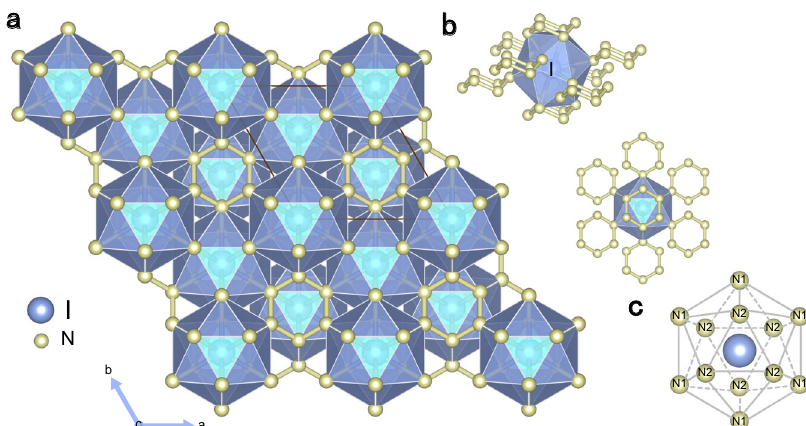
Fig. 2 Schematic representation of IN 6 crystal structure. a IN 6 in an R (cid:1) 3 m structure at 100 GPa. b The 12-fold coordination of iodine (IN 12 ) coordinated with nitrogen atoms from 8 armchair-like N 6 rings. c Schematic representation of the IN 12 icosahedron structure with D 3d point group symmetry. N1 and N2 represent the nitrogen atoms in the short and long I – Ν bonds,